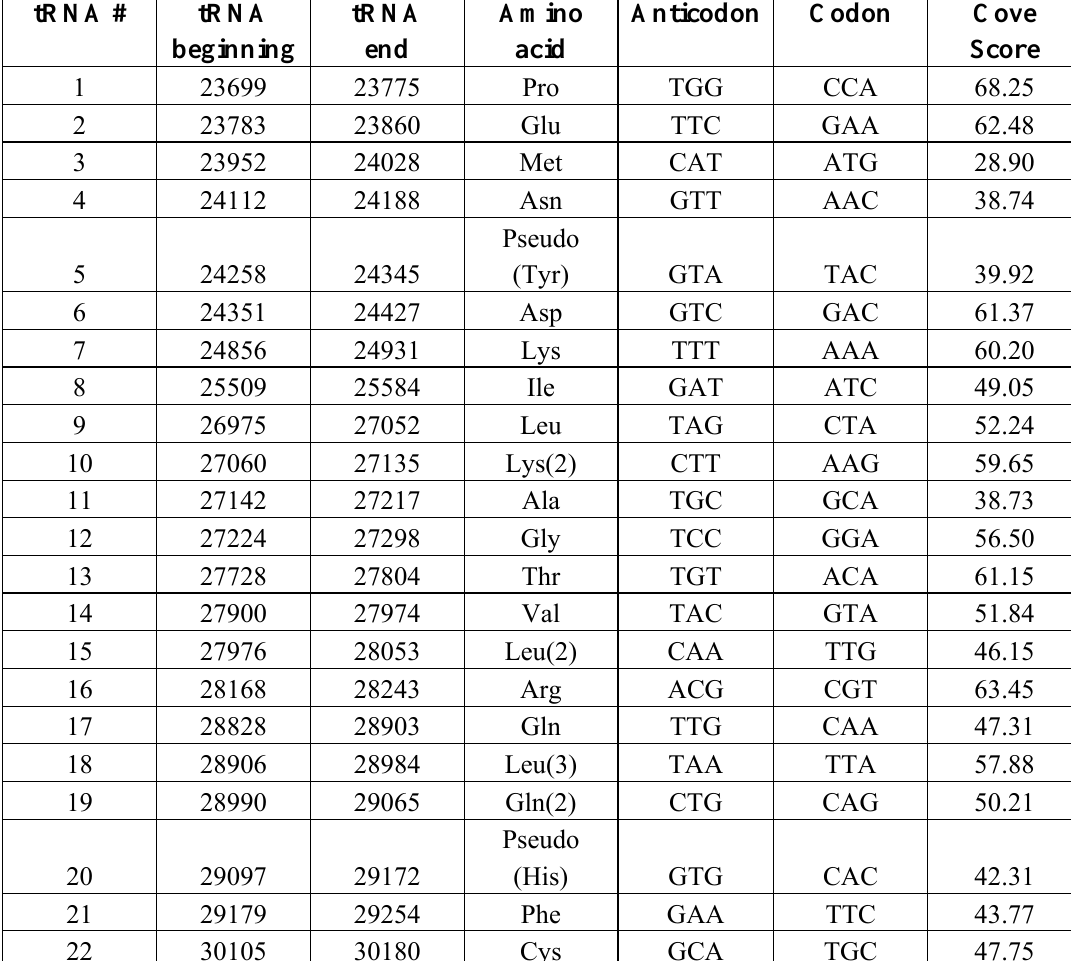
Table 1. Location of the tRNA genes in the Felix O1 genome, their cognate amino acids and